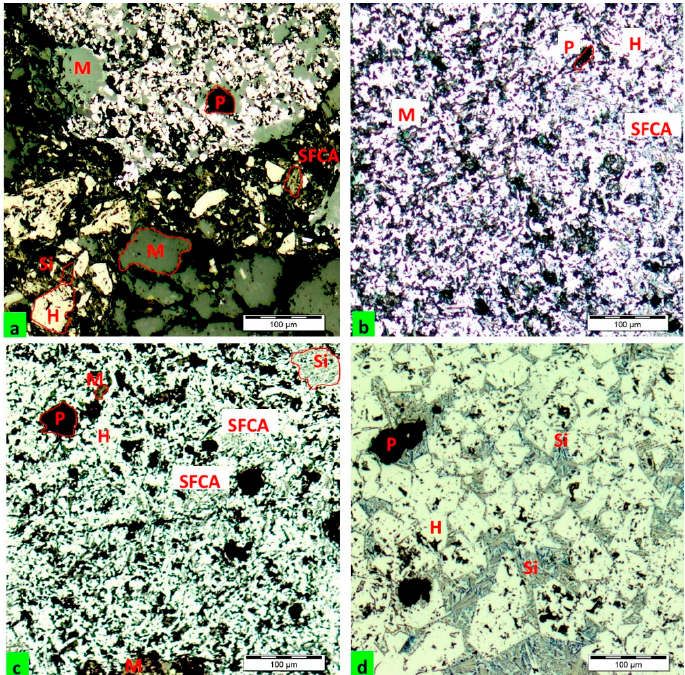
Figure 2. Microstructure of agglomerate produced using coke + lignin . ( a ) Coke; ( b ) coke + 20% lignin; ( c ) coke + 50% lignin; ( d ) coke + 86% lignin. M—magnetite; H—hematite; SFCA—silicoferrites of calcium and aluminum, SiCa—larnite.